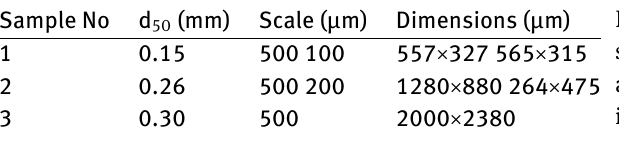
Table 3: Soil particle dimensions measured from SEM